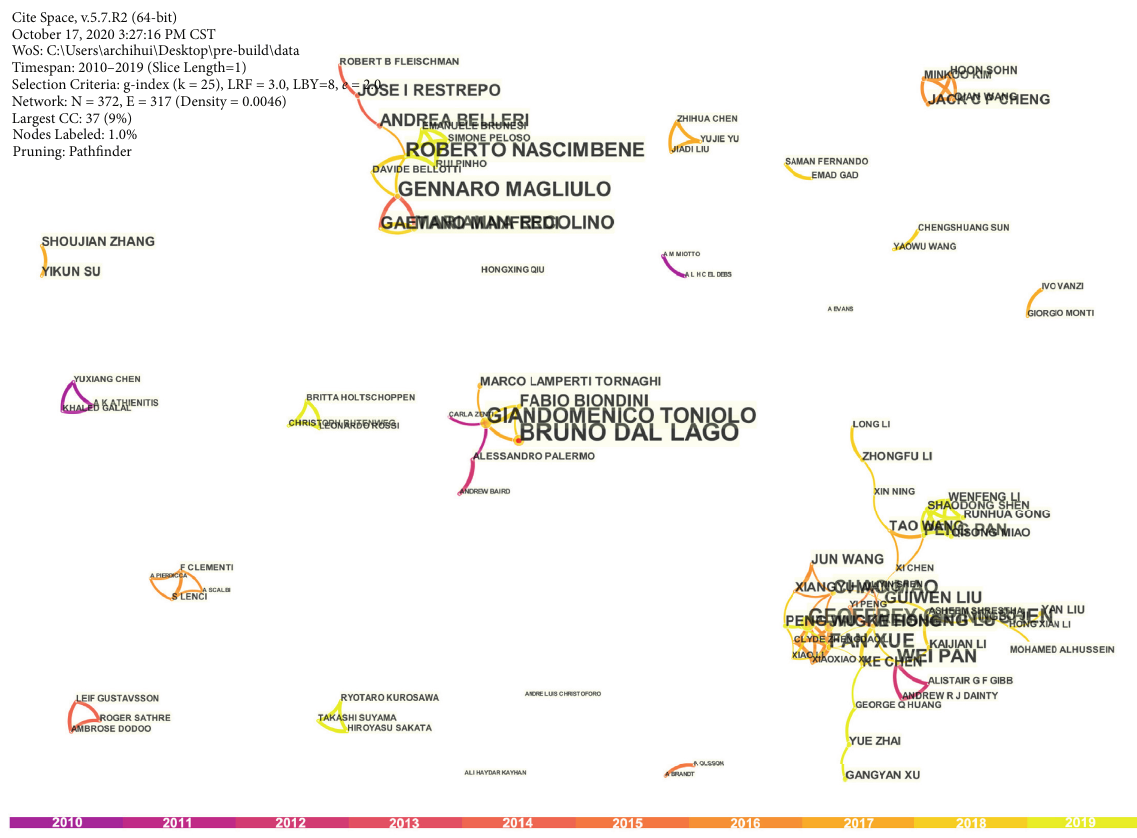
Figure 2: Co-authorship network and link colors corresponding to years